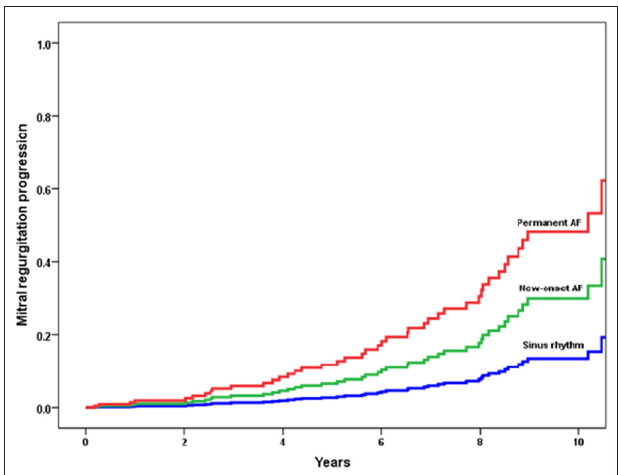
FIGURE 4 | Incidence of mitral regurgitation (MR) progression according to cardiac rhythm. Patients who had sinus rhythm at baseline but with a new-onset of atrial fibrillation during the follow-up were at risk for progression with a hazard ratio of 2.447 (95% CI 1.035–5.788). Patients with permanent atrial fibrillation were at the highest risk for progression with a hazard ratio of 4.459 (95% CI 2.148–9.631) when compared with patients in sinus rhythm.